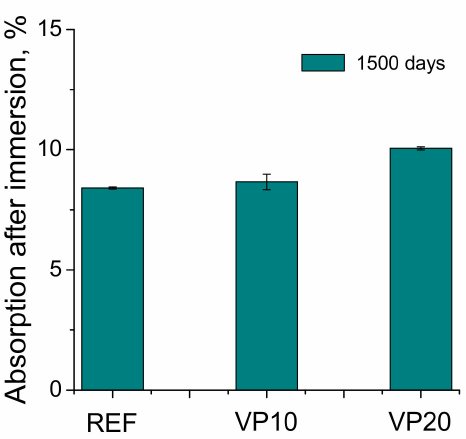
Figure 11. Percentage of absorption after immersion for the series analyzed.